Question: What kind of plot is shown here?
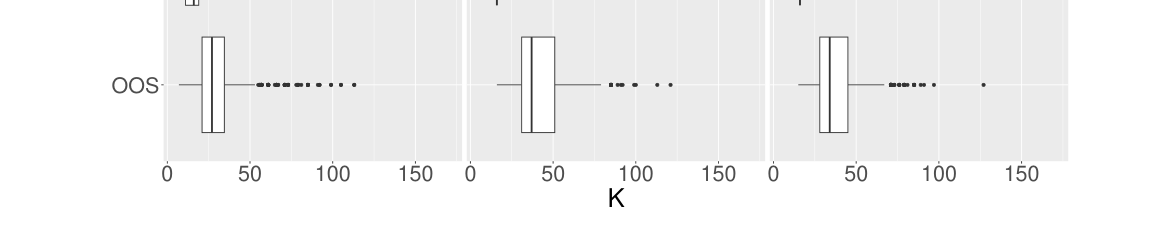
Answer: box